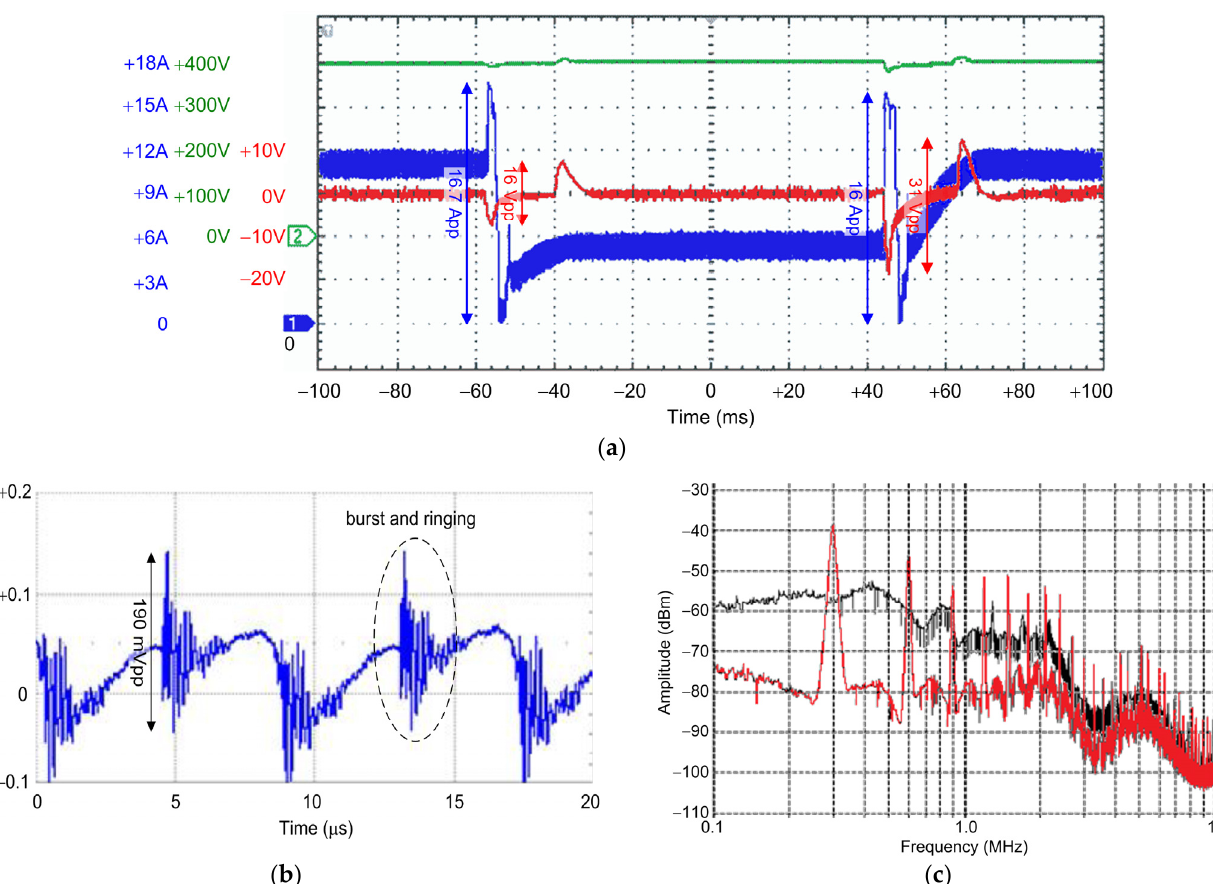
Figure 11. Exemplified harmonic/supraharmonic conducted disturbance: ( a ) resonant converter to interface a fuel cell with an electric vehicle [138]: V FC (light blue), I FC (blue), AC coupled V FC (red) where voltage transients are visible; ( b ) resonant DC/DC 400/12 V converter for data center [139]: AC coupled V out ; ( c ) random modulation DC/DC converter for Li-ion batteries [140]: deterministic modulation (red), random modulation (black).